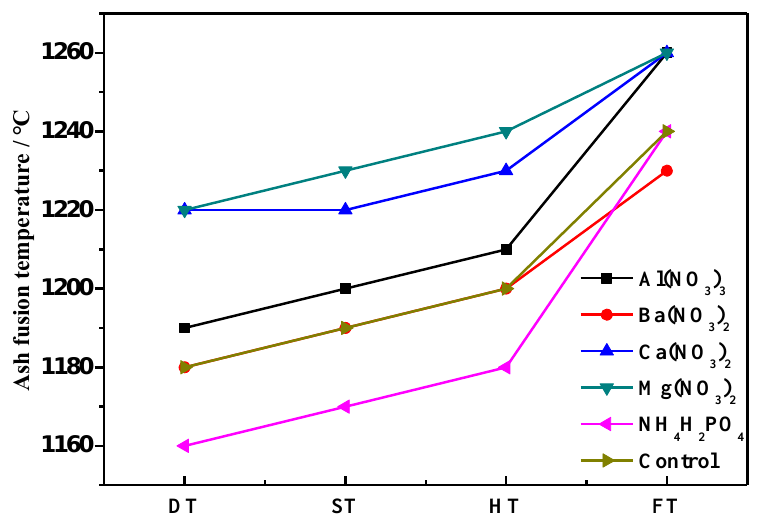
Figure 9. Effect of various potential additives on the ash fusion temperature, DT: the initial deforma- tion temperature, ST: softening temperature, HT: hemispherical temperature, FT: flow tempera- ture.